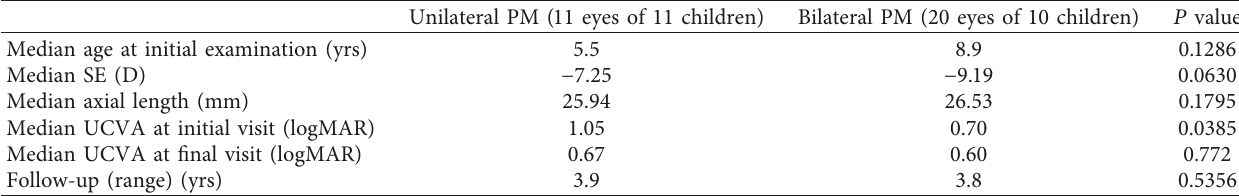
Table 3: Comparison of clinical characteristics between bilateral and unilateral pathological myopia in children at the initial visit.